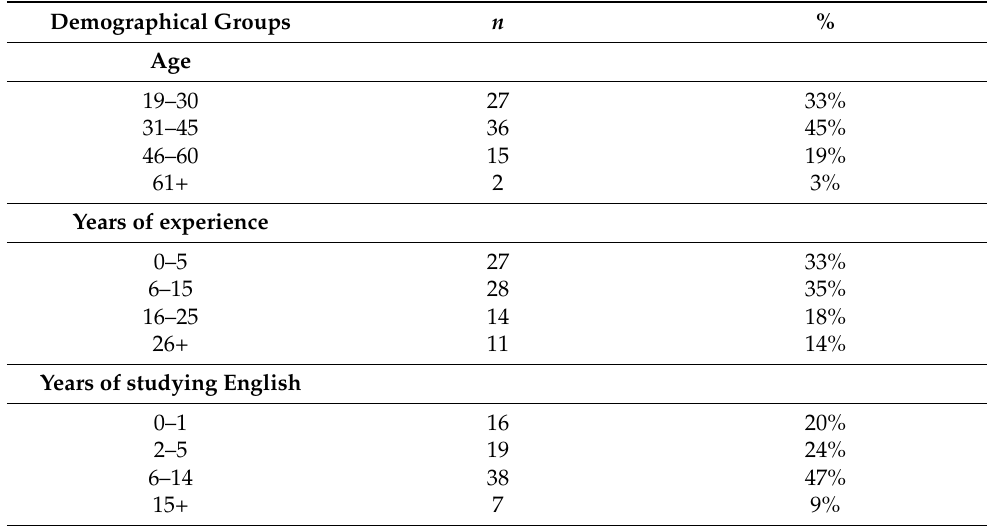
Table 1. Demographical